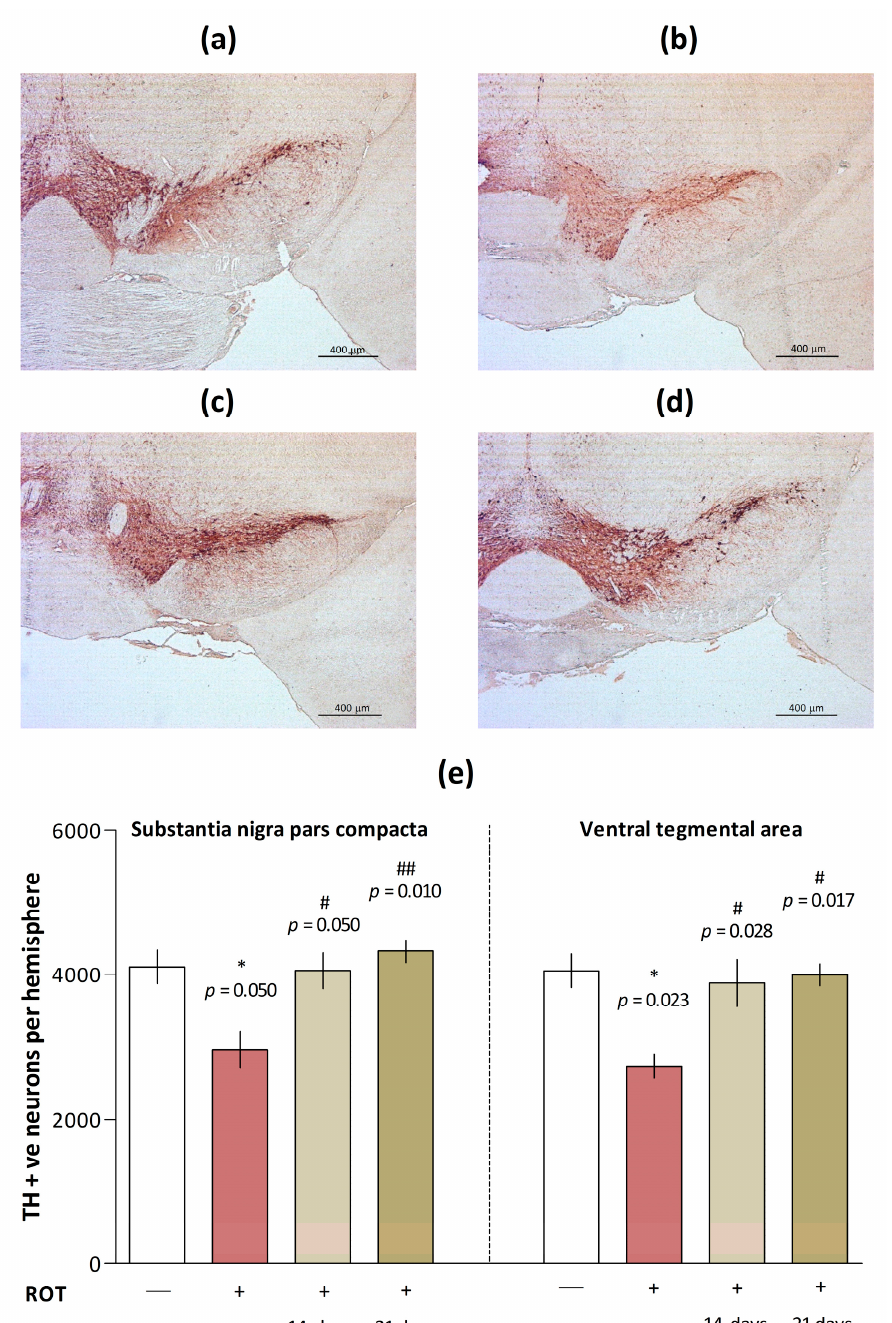
Figure 9. Post mortem analysis of the number of dopaminergic neurons in the mice brain regions. Representative images of brain sections of Control ( a ), ROT ( b ), ROT + E-diol (I) ( c ) and ROT + E-diol (II) ( d ) through substantia nigra pars compacta (SNpc) and ventral tegmental area (VTA) regions immunostained with an anti-tyrosine hydroxylase antibody (TH, mouse monoclonal antibody, clone TH-2, Sigma diluted 1:1000). The scale bar represents 400 µ M. Histograms showing the number of TH-positive neurons in individual brain regions ( e ). The data are presented as mean ± SEM, n = 8. To assess the statistical significance, one-way ANOVA and Kruskal–Wallis’ multiple comparison tests were used, where * p ≤ 0.05 versus control; # p ≤ 0.05 and ## p ≤ 0.01 versus